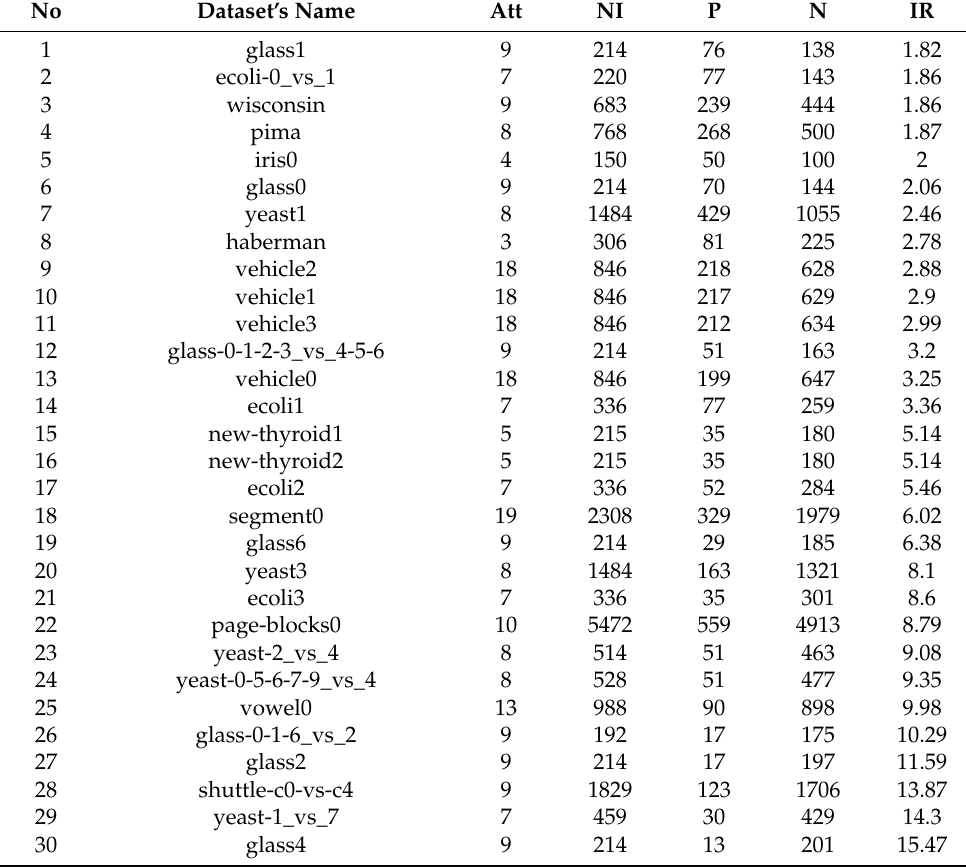
Table 2. Datasets